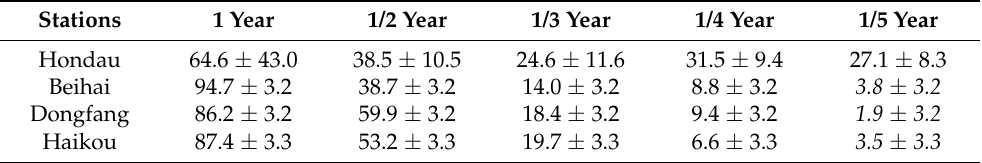
Table 6. The amplitudes and errors (unit: mm) of the seasonal and subseasonal cycles in monthly mean water levels (MMWLs) at Hondau, Beihai, Dongfang and Haikou. Amplitude errors are obtained based on 95% confidence intervals [15]. Statistically insignificant results are labeled by italic